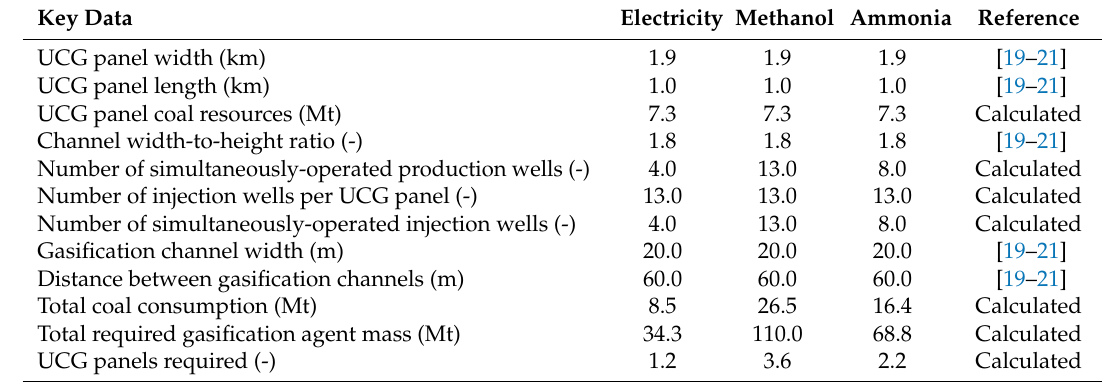
Table 2. UCG design for a 2 km × 1 km-sized target area adapted from Otto et al. [19] and adjusted to the electricity, methanol, and ammonia production